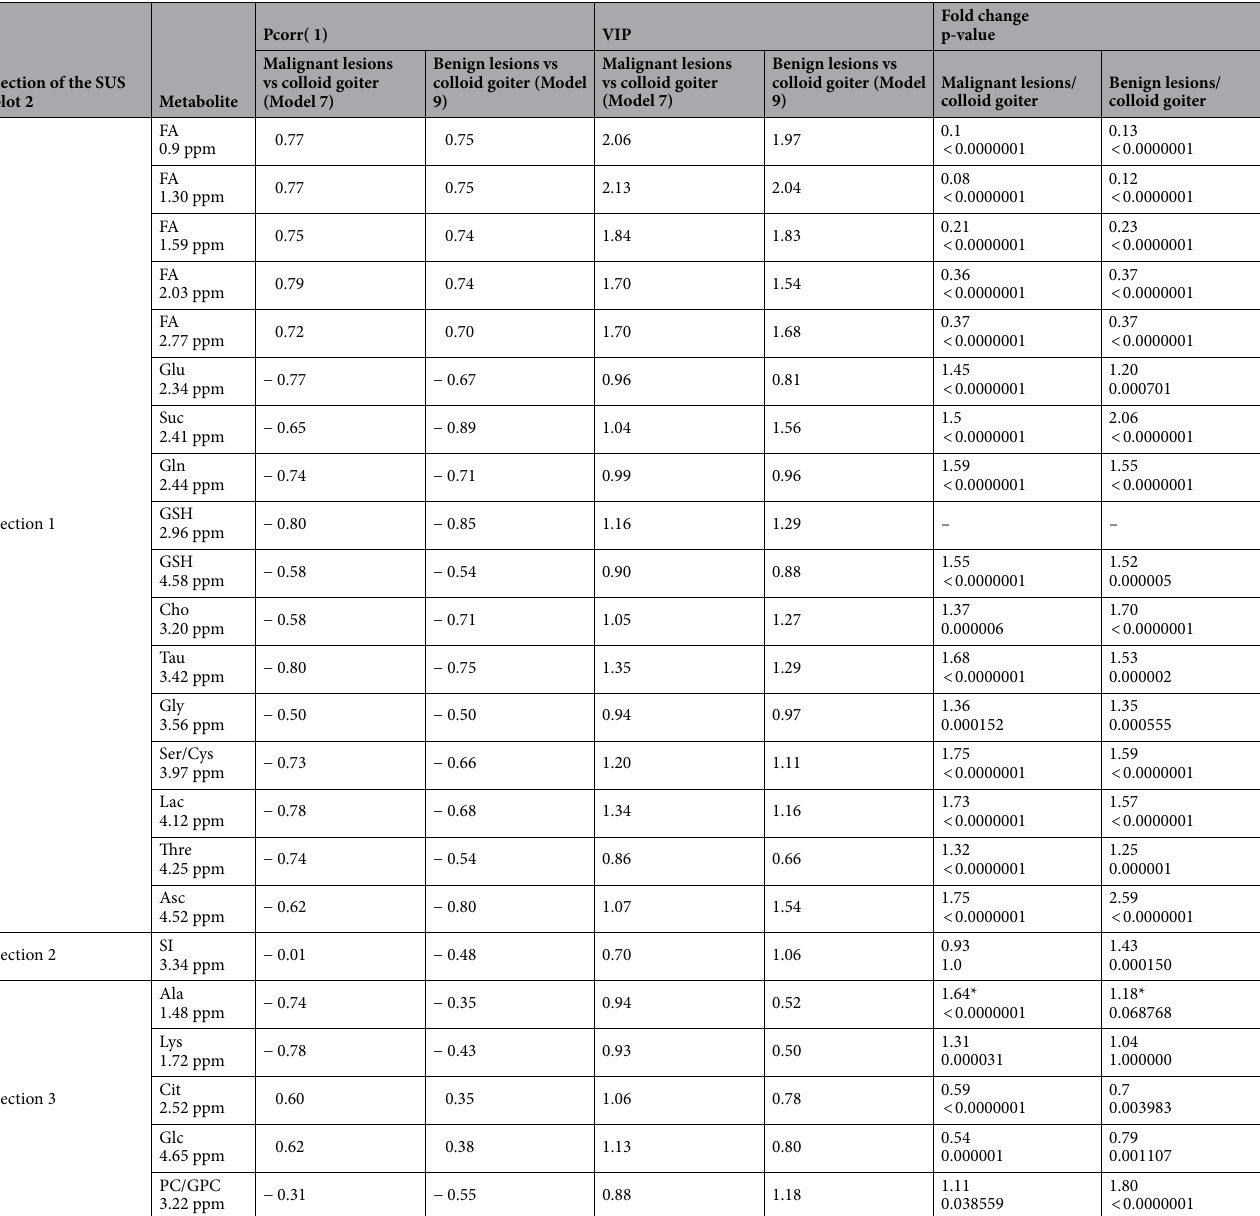
Table 1. The pcorr (1) and VIP values obtained from the OPLS-DA models 7 and 9, the fold-changes (ratios of median metabolite levels in the lesions to the median metabolite levels in the non-tumoral tissue) and p values from the univariate analysis (post-host analysis by means of multiple comparisons of mean ranks) for the metabolites contributing to the class separation. Positive (negative) pcorr(1) values indicate a relatively higher (lower) metabolite level in the non-tumoral tissue than in the lesions. *Signal intensites were analyzed instead of signal